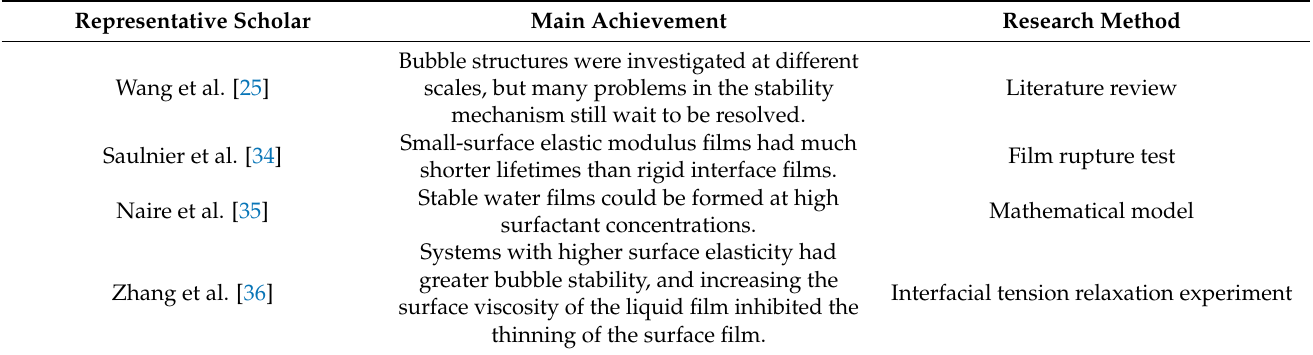
Table 1. Study on bubble stability and liquid film strength.